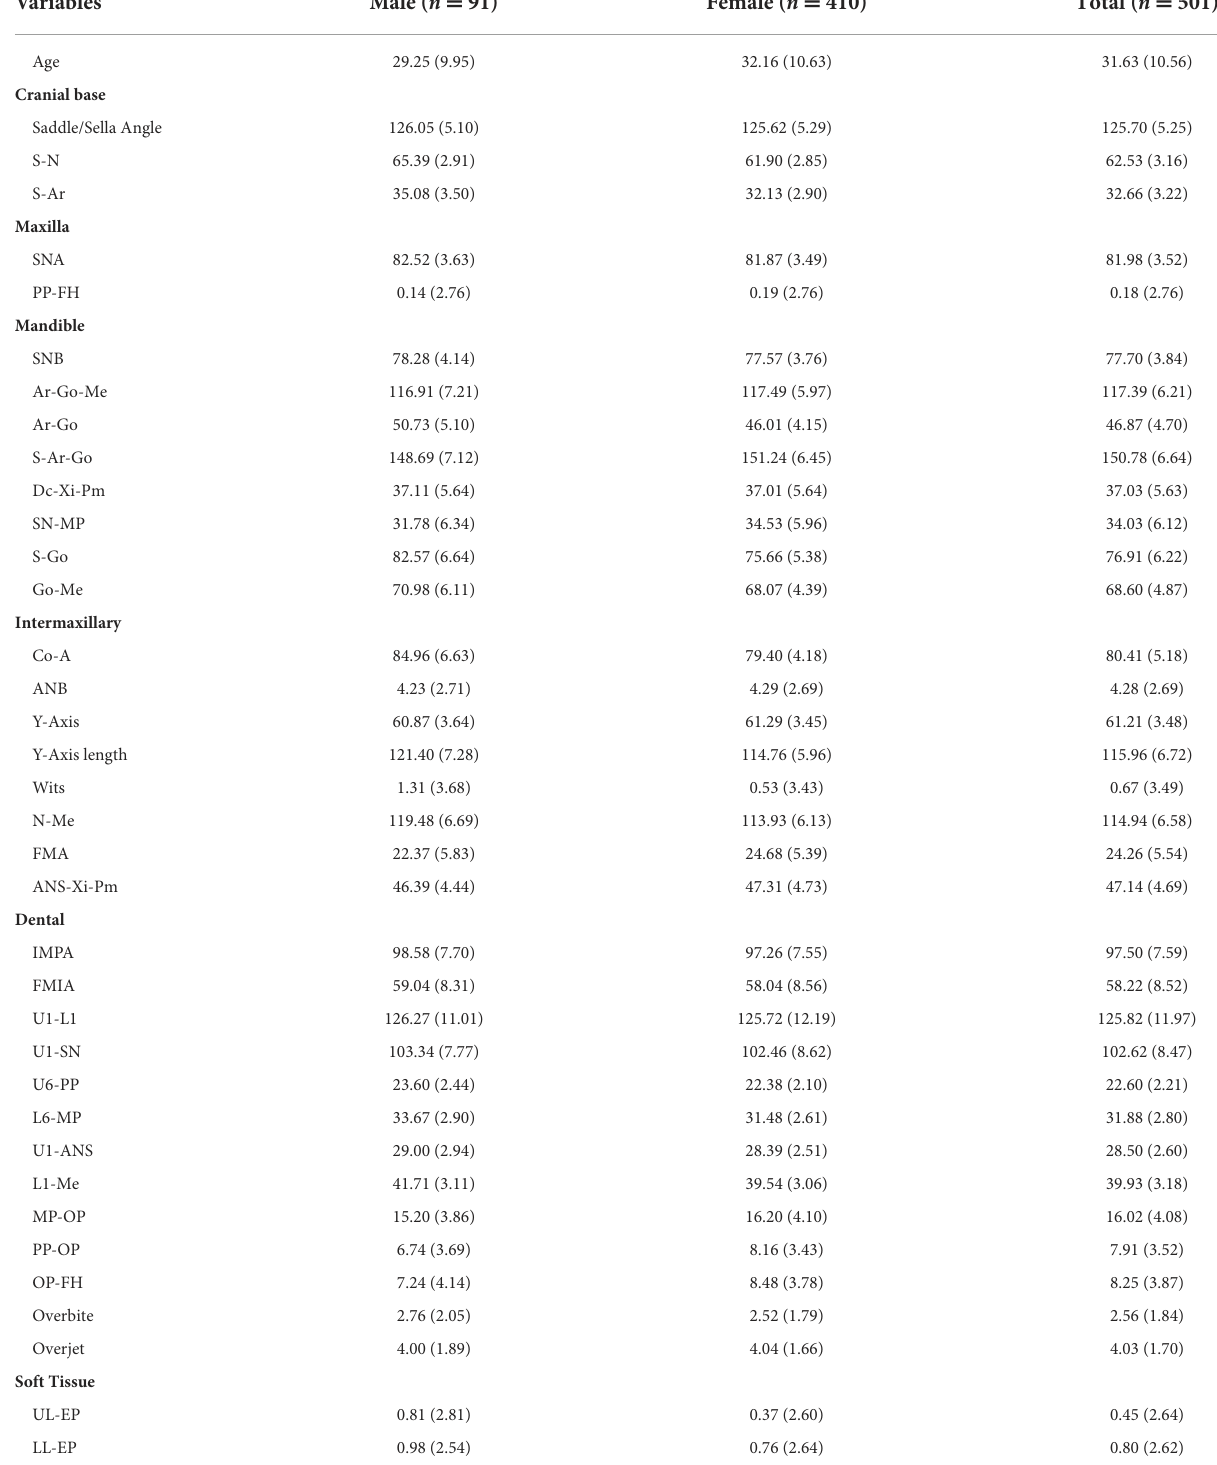
TABLE 2 Baseline characteristics of the cephalometric